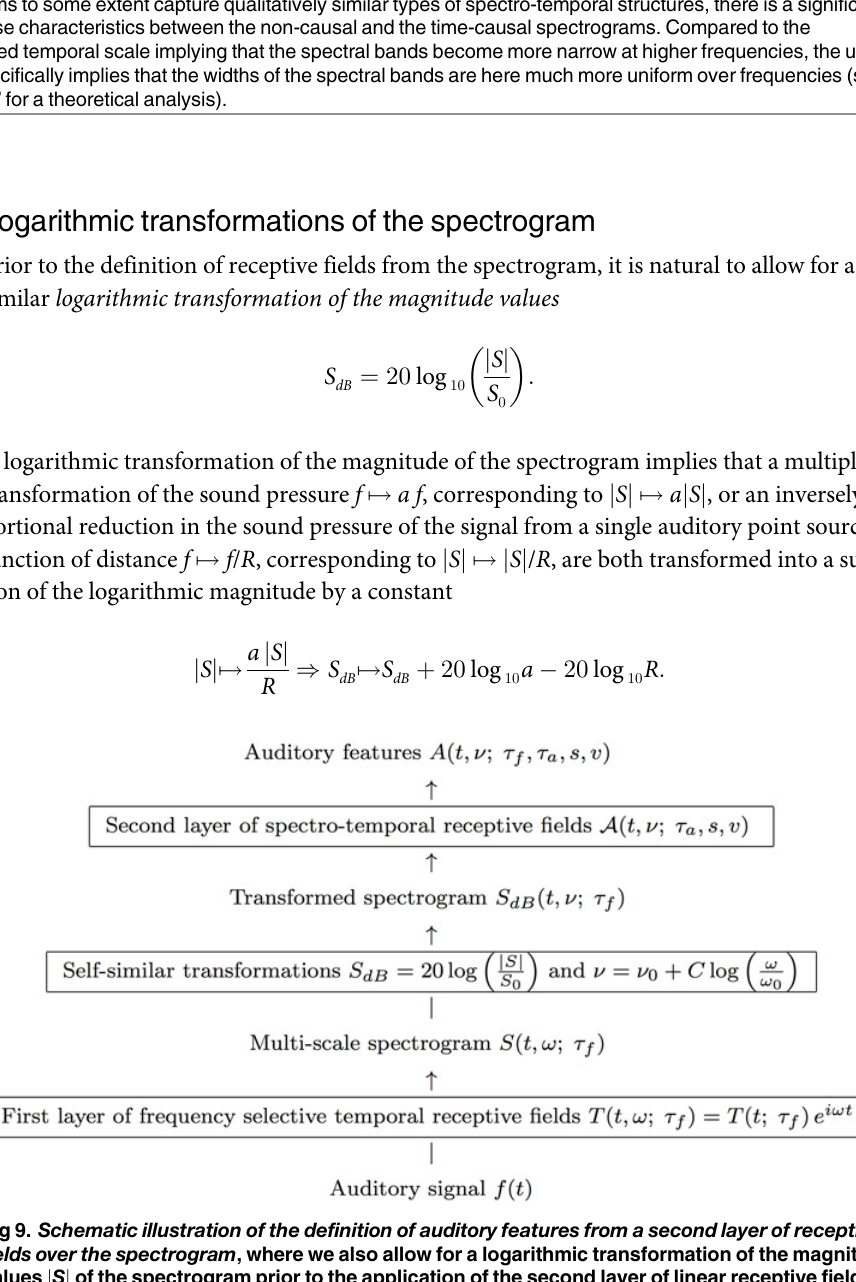
(cid:5) (cid:6) Þ before defining the o 0